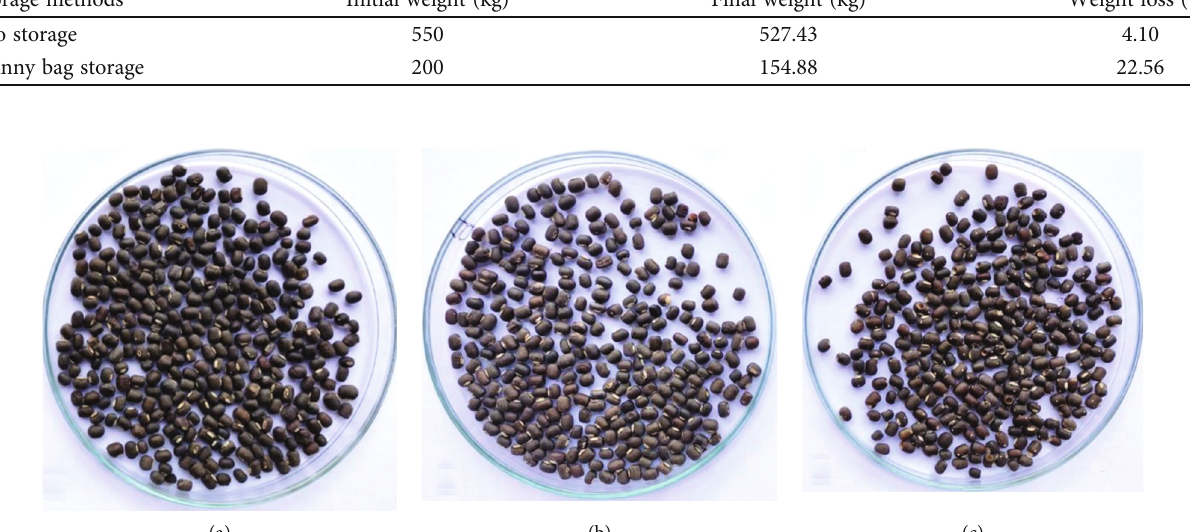
Figure 10: Black gram grain samples (a) before storage; (b) after controlled atmosphere storage; (c) after gunny bag